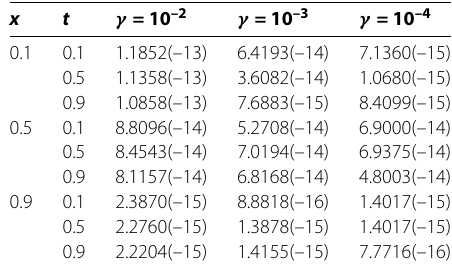
Table 12 Example 4: Case 4.3: Maximum absolute errors